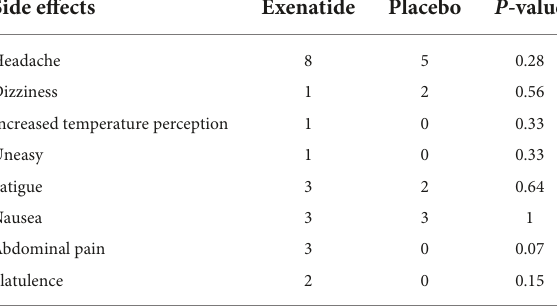
Table over registered side effects. Results are shown as the number of subjects who experienced the specific side effects in the different treatment groups. P -values are from thestatisticalunpairedsampled t